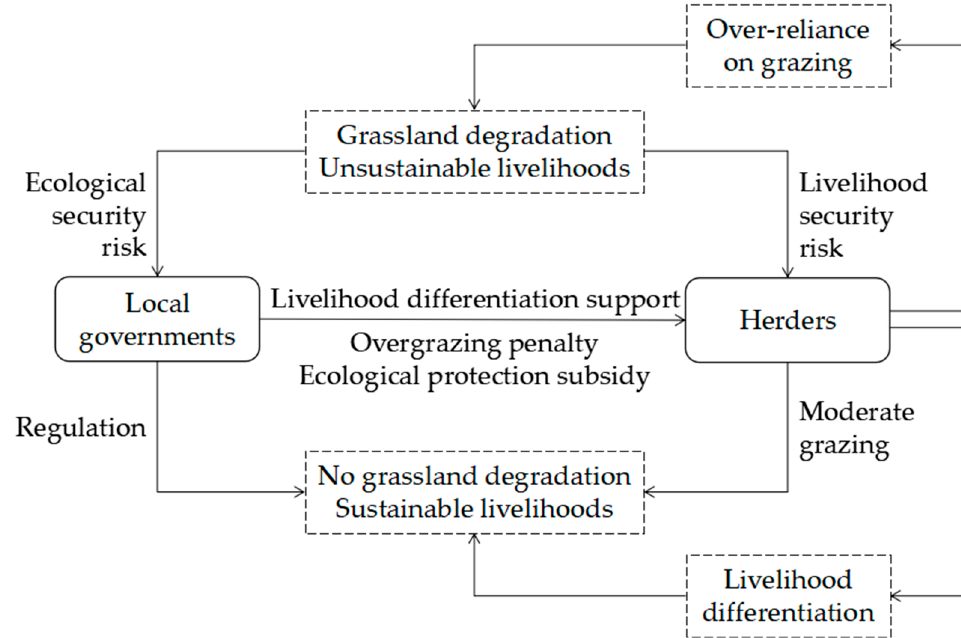
Figure 1. Theoretical framework.